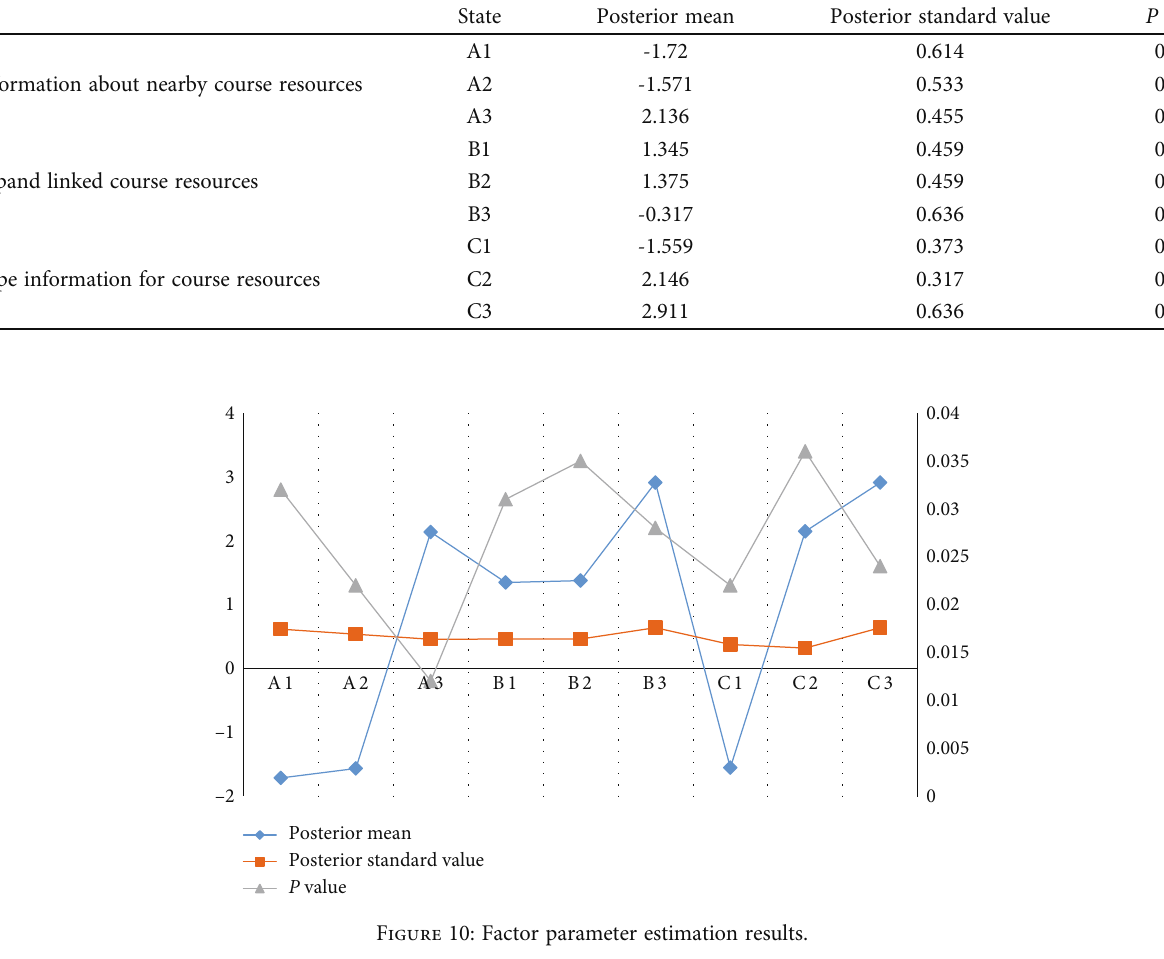
Table 4: Description of the parameter estimation results of in fl uencing